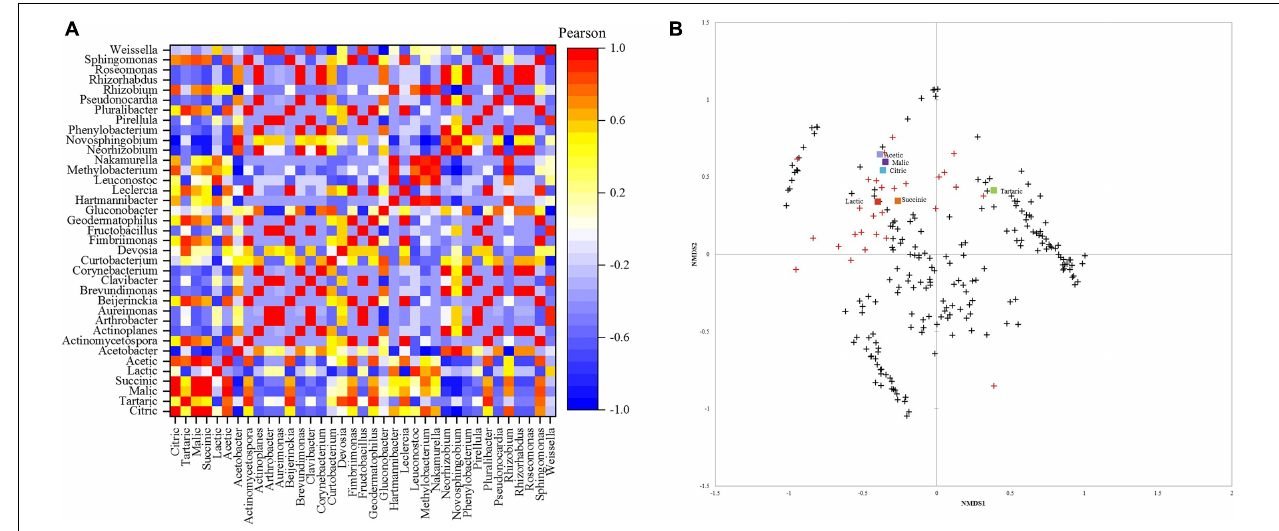
FIGURE 4 | (A) Pearson correlation matrix of bacterial genera and acids. (B) Non-metric multidimensional scaling (NMDS) using Bray-Curtis dissimilarity for eukaryotic species and organic acids. + species below 1% and + abundant species above 1%.